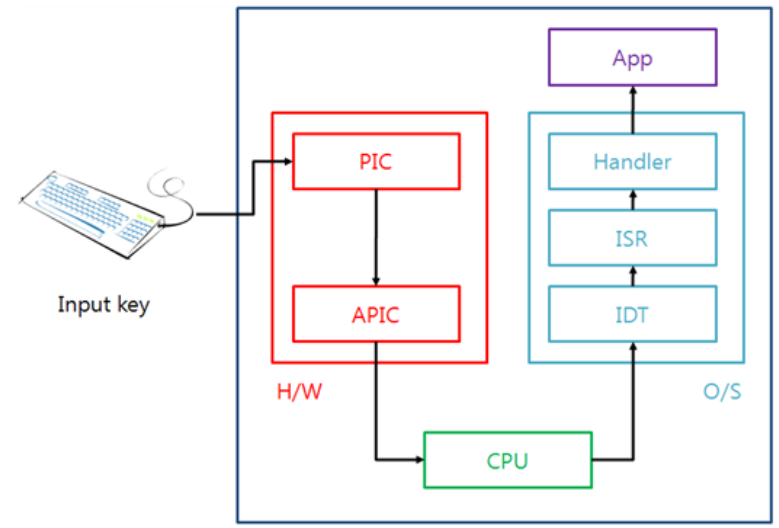
Figure 2. Transferal process of the keyboard data .